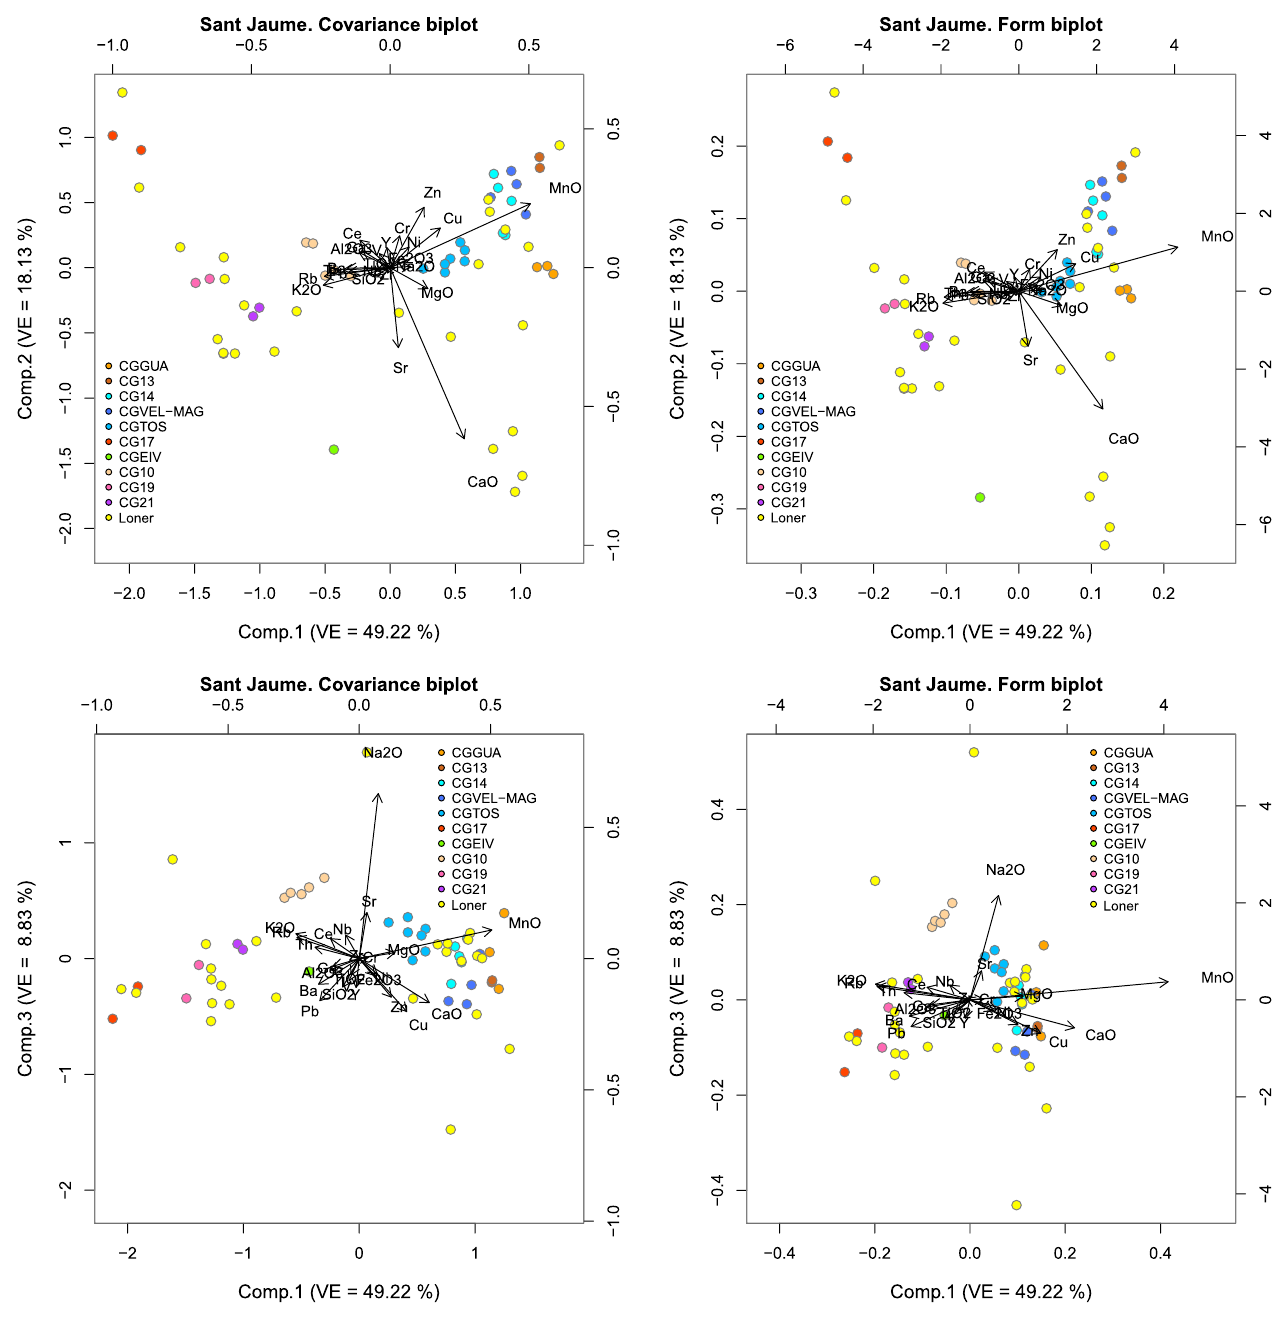
Figure 6. Biplots of the singular value decomposition on the double-centred clr transformed subcomposition Na 2 O, MgO, Al 2 O 3 , SiO 2 , K 2 O, CaO, TiO 2 , V, Cr, MnO, Fe 2 O 3 , Ni, Cu, Zn, Ga, Rb, Sr, Y, Zr, Nb, Ba, Ce, Pb, and Th. ( Top ): principal components 1 and 2. ( Bottom ): principal components 1 and 3. ( Left ): covariance biplot. ( Right ): form a biplot. VE: variance explained.